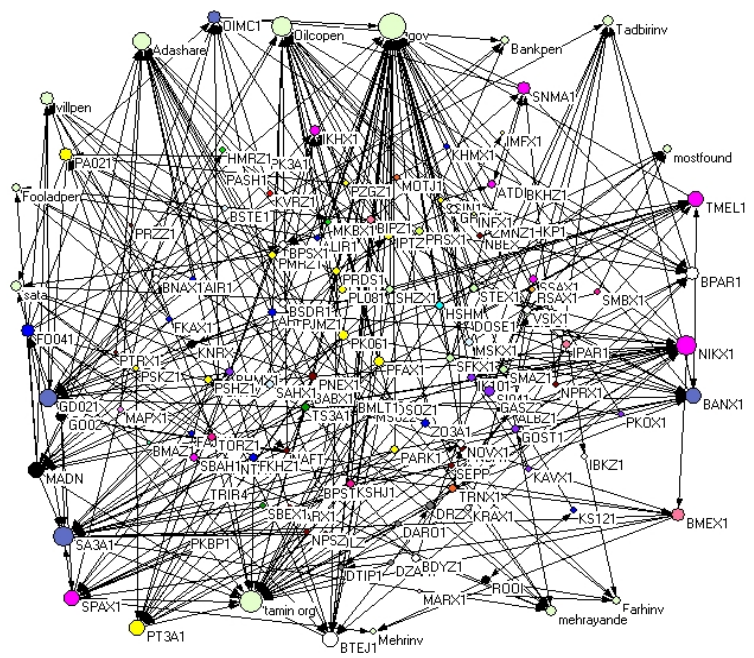
Figure 3. Representation of cross-shareholding network of Tehran Stock Exchange. The size of nodes is related to the degree of each node and the degree is the sum of in-degree and out-degree of nodes. Table 2. Comparison of different systemic risk indices of direct network in the Tehran Stock Exchange. Degree In-Degree Out-Degree Min. Degree